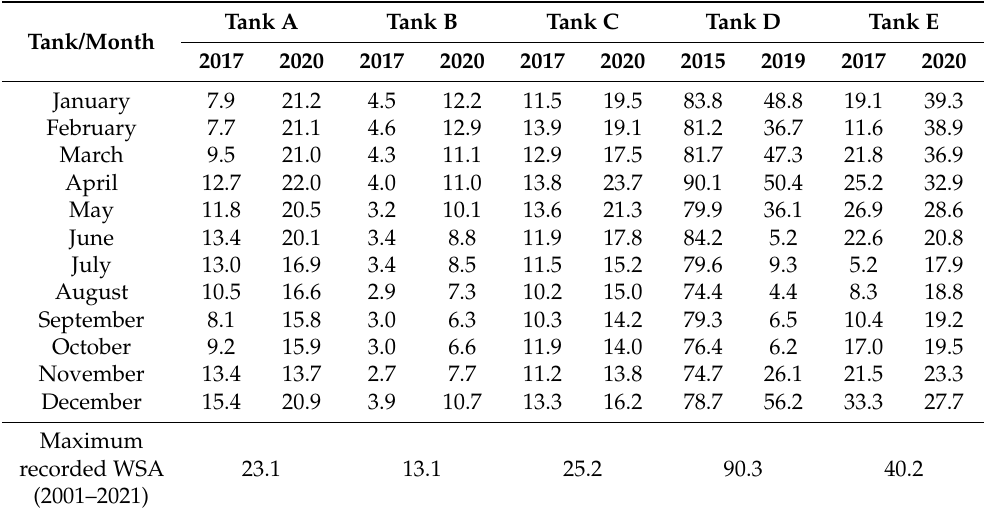
Table 3. Water surface area in square kilometers (sq.km) for drought (2017 and 2019) year, non- drought year (2015 and 2020), and maximum recorded water surface area from 2001 to 2020. Tank Tank/Month